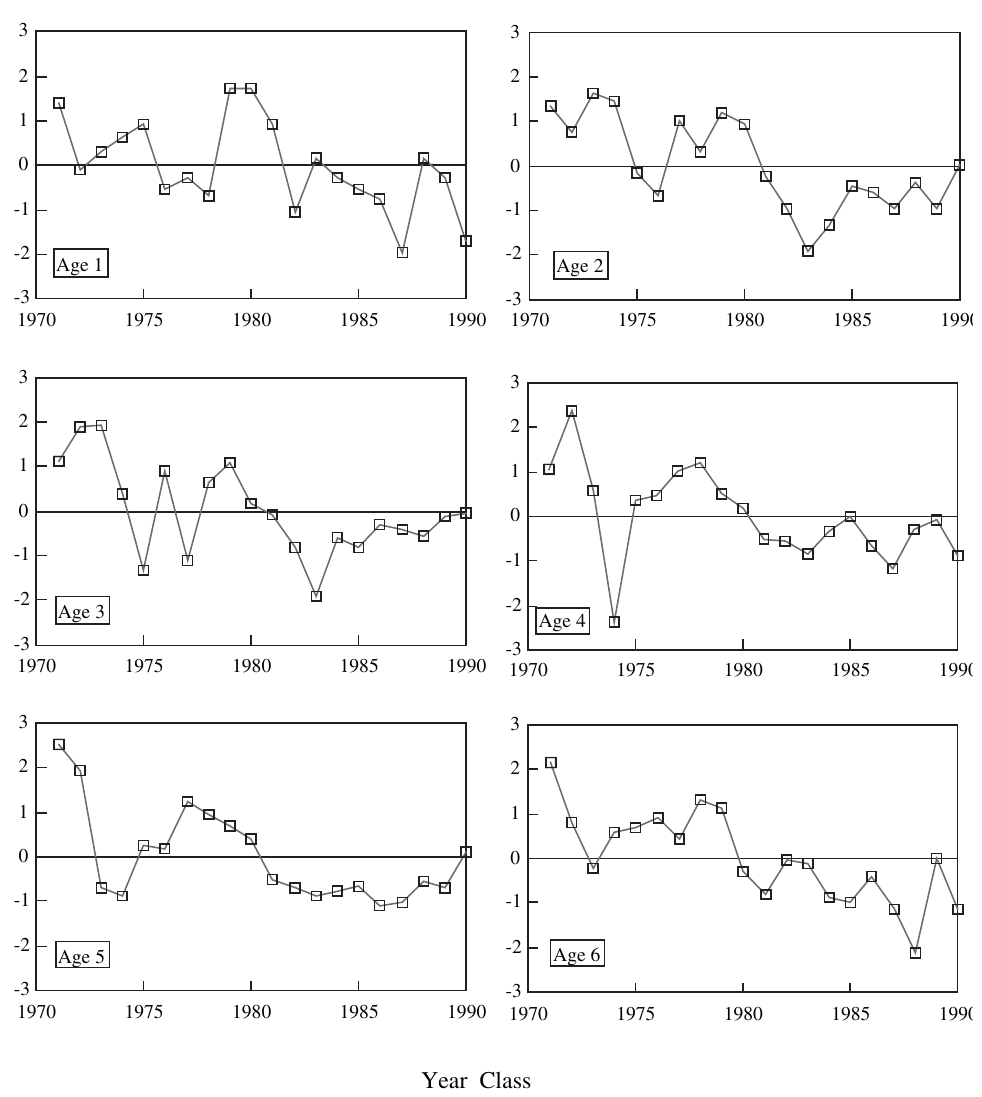
Fig . 2. – Plot of standardized size-at-age data for six age groups of 20 year-classes from 1971 to